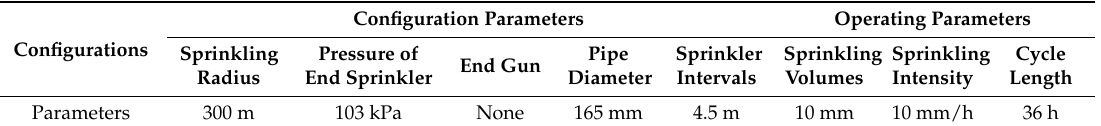
Table 3. Configurations and operating parameters of the simulated center pivot irrigation